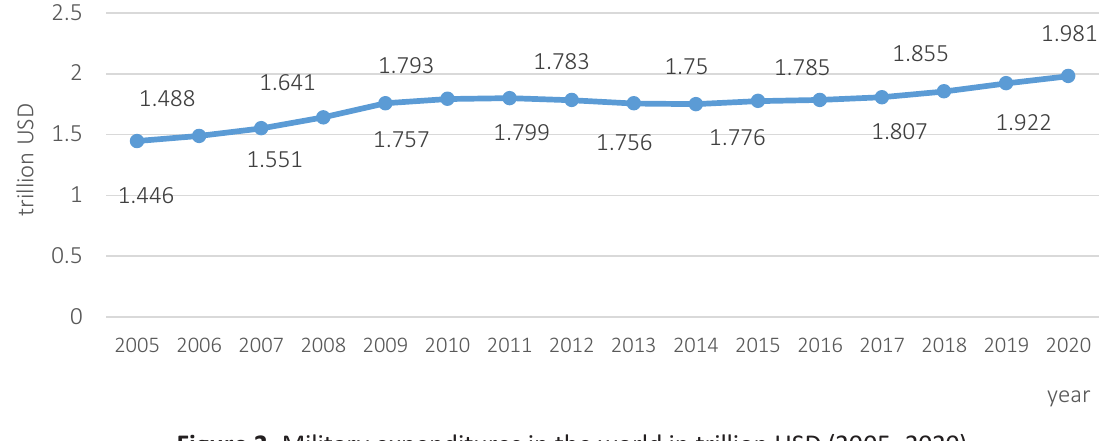
Figure 2. Military expenditures in the world in trillion USD (2005–2020)